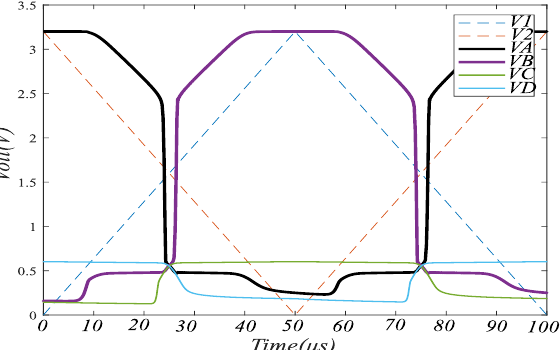
Figure 9. Simulation result of voltages VA and VB in Figure 8a and Voltages VC and VD in Figure 8b. Figure 10 shows the simulation of the proposed bump circuit and the classic one when a differential voltage is applied to their inputs. The solid black and red colored curves marked I tot are the total current consumption of the classic bump circuit and the new proposed circuit, respectively. The variation in current consumption of the proposed bump circuit follows a bell-shaped curve.